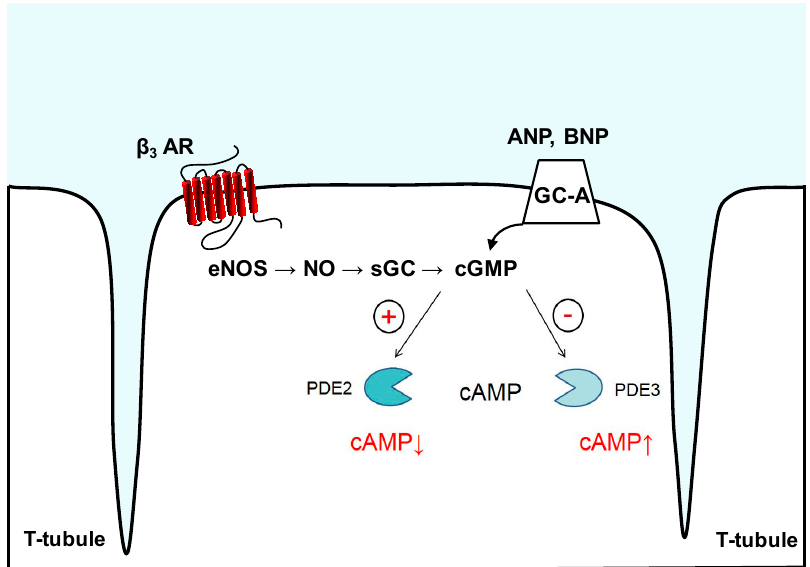
Figure 2. PDE2- and PDE3-mediated cyclic nucleotide crosstalk. cGMP synthesis occurs by pGCs such as GC-A, which serves as a membrane receptor for ANP and BNP, or by NO-activated sGC, e.g., downstream of eNOS and β 3 -adrenoreceptor ( β 3 -AR). Binding of cGMP to PDE2 can allosterically increase its hydrolytic activity, lowering cAMP levels in subcellular microdomains. PDE3 is a “cGMP-inhibited” phosphodiesterase that upon cGMP binding and degradation in the catalytic domain shows reduced rates of cAMP hydrolysis, generating a positive cGMP-to-cAMP cross-talk.